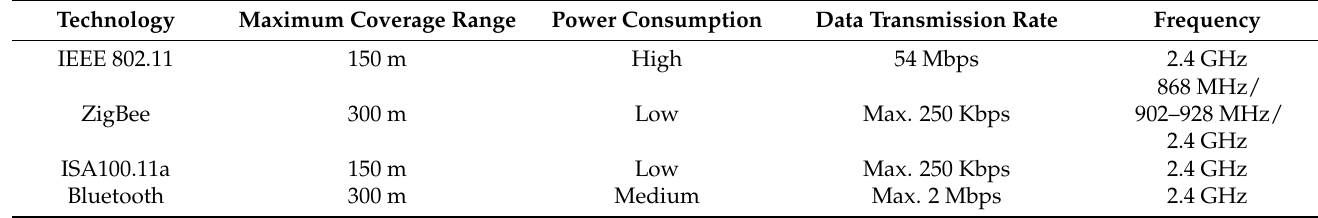
Table 2. Common wireless data communication